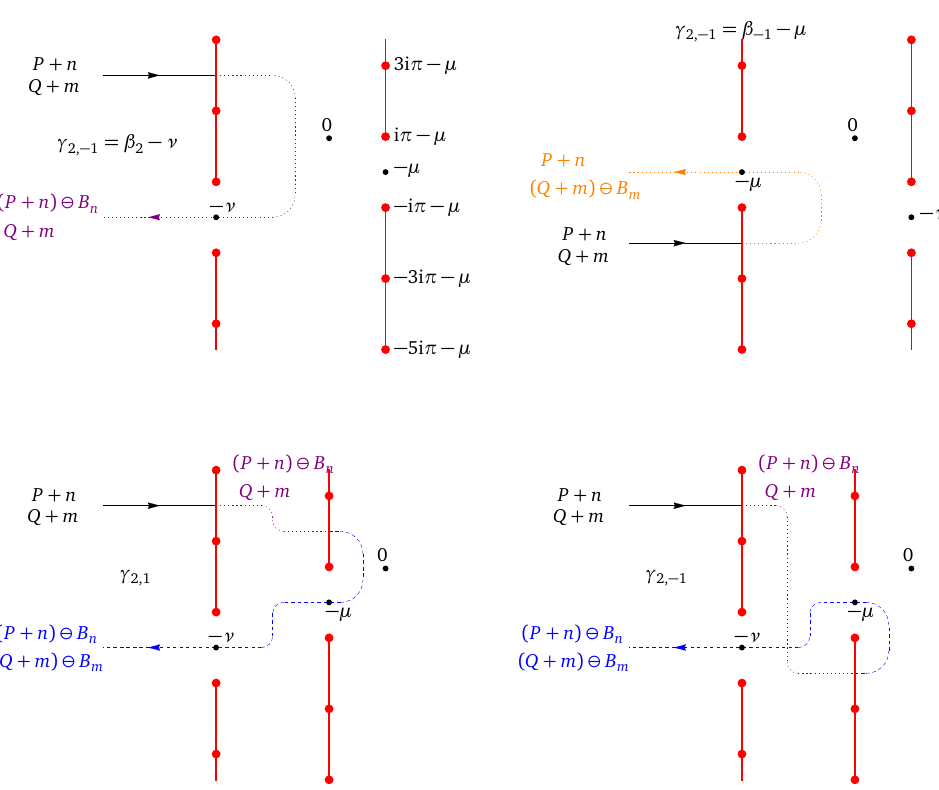
Figure 23: Path γ in (102) plotted for some choices of ν , µ ∈ (cid:68) , n , m ∈ (cid:90) . From n , m = β − ν for Re µ < 0 < Re ν , left to right, top to bottom, the graphs represent γ 2, − 1 2 γ = β − µ for Re ν < 0 < Re µ , γ for 0 < Re µ < Re ν , and γ for − 1 2, − 1 2,1 2, − 1 0 < Re µ < Re ν . The smaller, black dots represent the points 0, − ν , − µ . The big- ger, red dots represent the branch points − ν + 2i π a , − µ + 2i π a , a ∈ (cid:90) + 1 / 2 of χ (cid:48)(cid:48) ( · + ν ) χ (cid:48)(cid:48) ( · + µ ) , and the vertical, red lines the associated branch cuts. The P + n Q + m solid / dotted / dashed portions of the path γ correspond to distinct values of the n , m ( u + ν ) χ (cid:48)(cid:48) ( u + µ ) = A ( χ (cid:48)(cid:48) ( · + ν ) χ (cid:48)(cid:48) ( · + µ )) which are indicated sets ˆ P , ˆ Q in χ (cid:48)(cid:48) u P + n Q + m ˆ P ˆ Q next to the